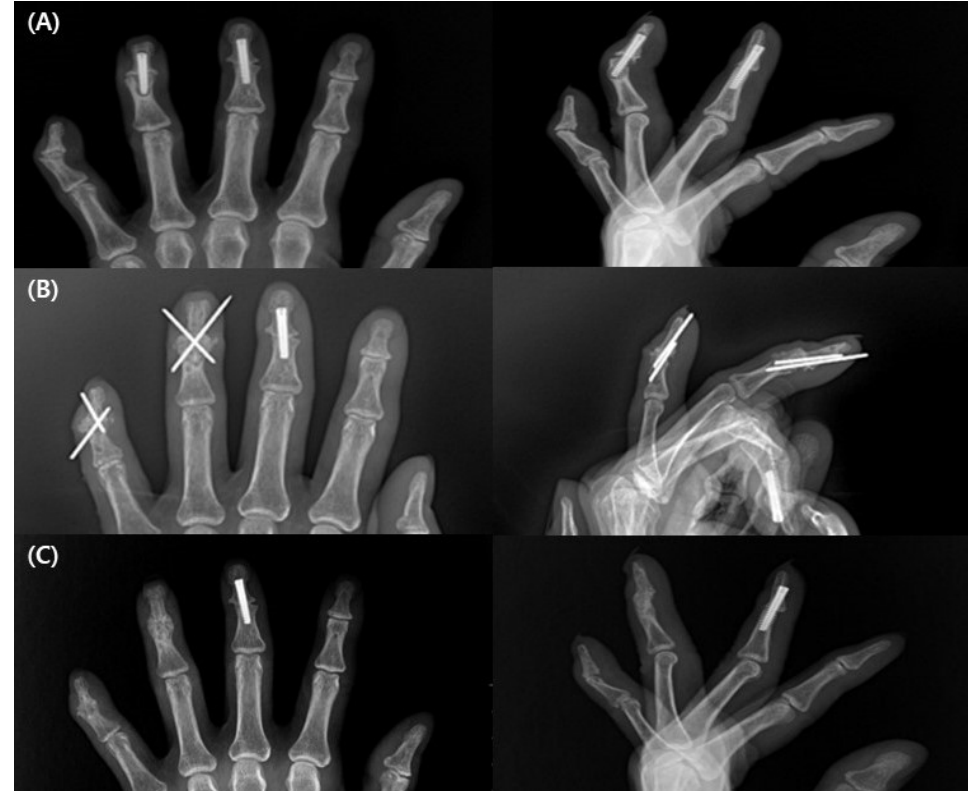
Figure 3. A 62-year-old woman underwent 3rd, 4th, and 5th distal interphalangeal joint (DIP) arthrodesis. ( A ) At 16 weeks after the initial surgery, pain and tenderness were sustained and radiograph shows no evidence of union with 4th and 5th DIP joint. The 5th finger was secured with K-wires, and the 3rd and 4th fingers were secured with Acutrak screws at initial surgery. ( B ) Post revision surgery with K-wires and inlay technique with cortico-cancellous olecranon bone graft. ( C ) The bony union achieved radiographically at 6 weeks after the revision surgery.